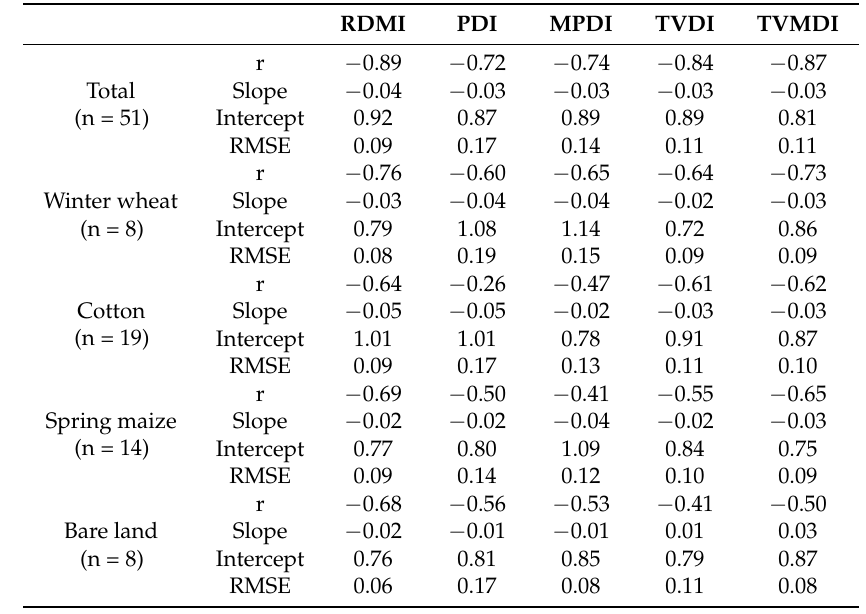
Table 4. The correlation coefficients, slope, intercept, and RMSE of RDMI, Perpendicular Drought Index (PDI), Modified Perpendicular Drought Index (MPDI), TVDI, and TVMDI, under different land cover conditions (n is the amount of in-situ data under this land